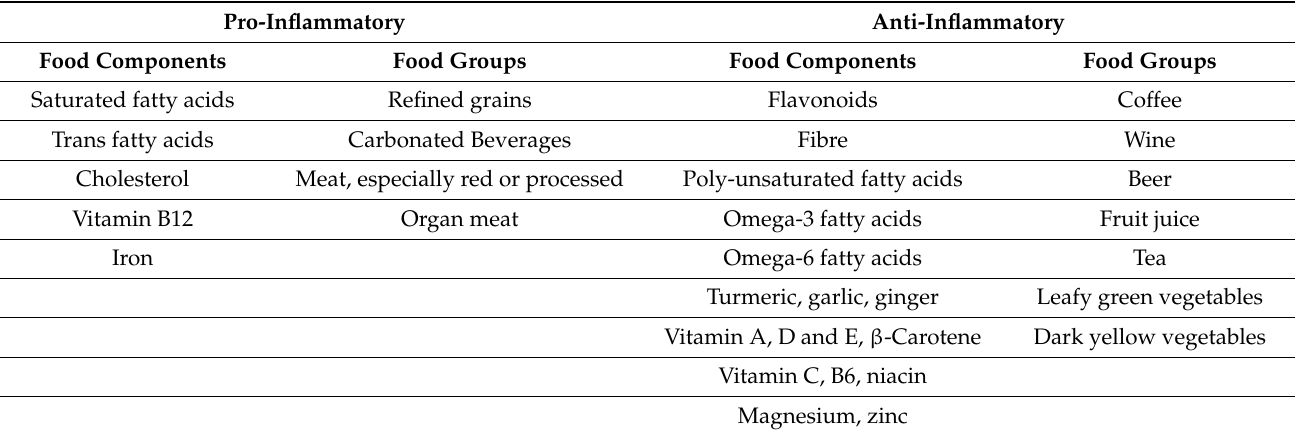
Table 1. Overview of selected pro-inflammatory and anti-inflammatory food components according to the Dietary Inflammatory Index (DII) [39] and food groups according to the Empirical Dietary Inflammatory Index (EDII)